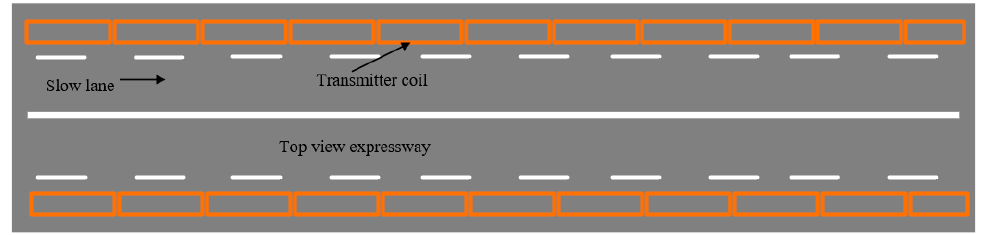
Figure 2. Schematic diagram of the laying of the transmitting coil of the expressway.